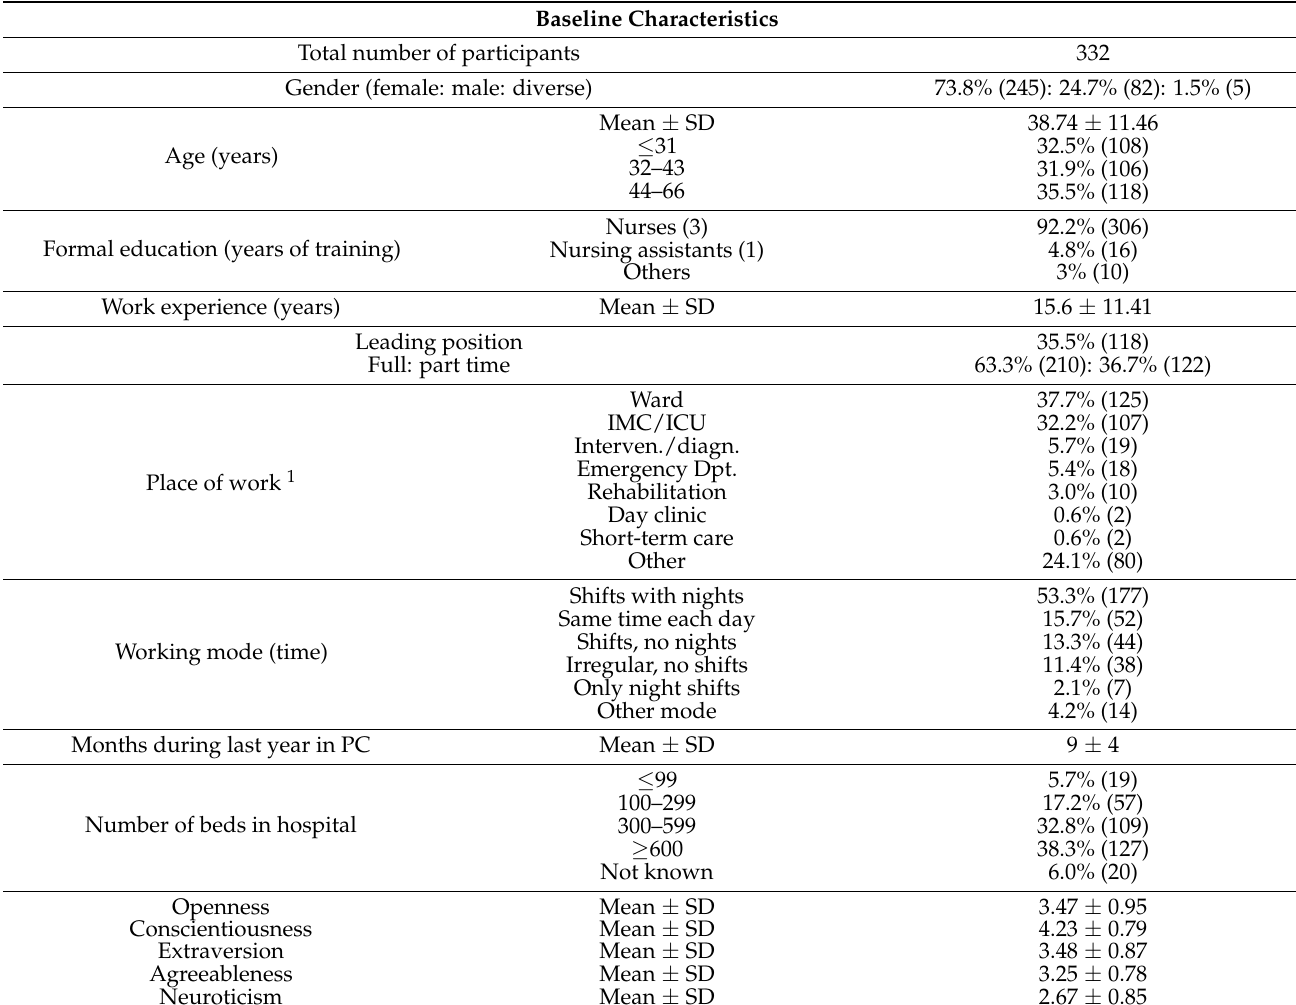
Table 2. Baseline characteristics of the study